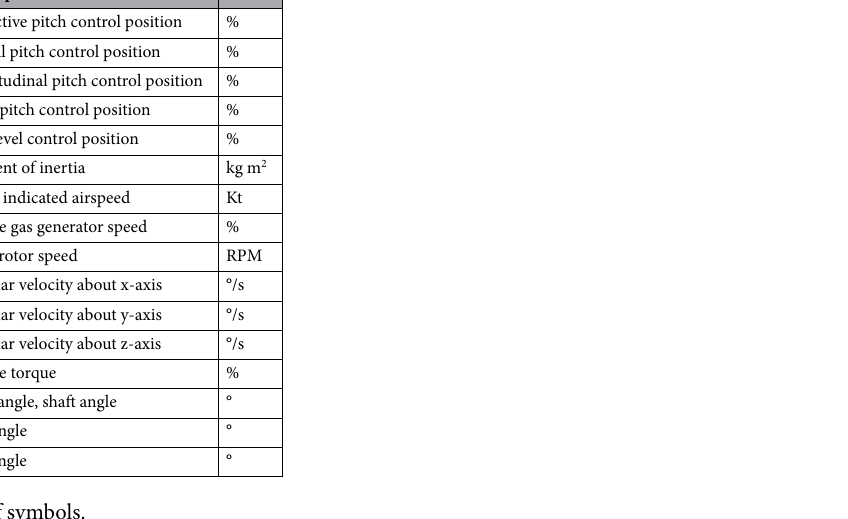
Table 1. List of